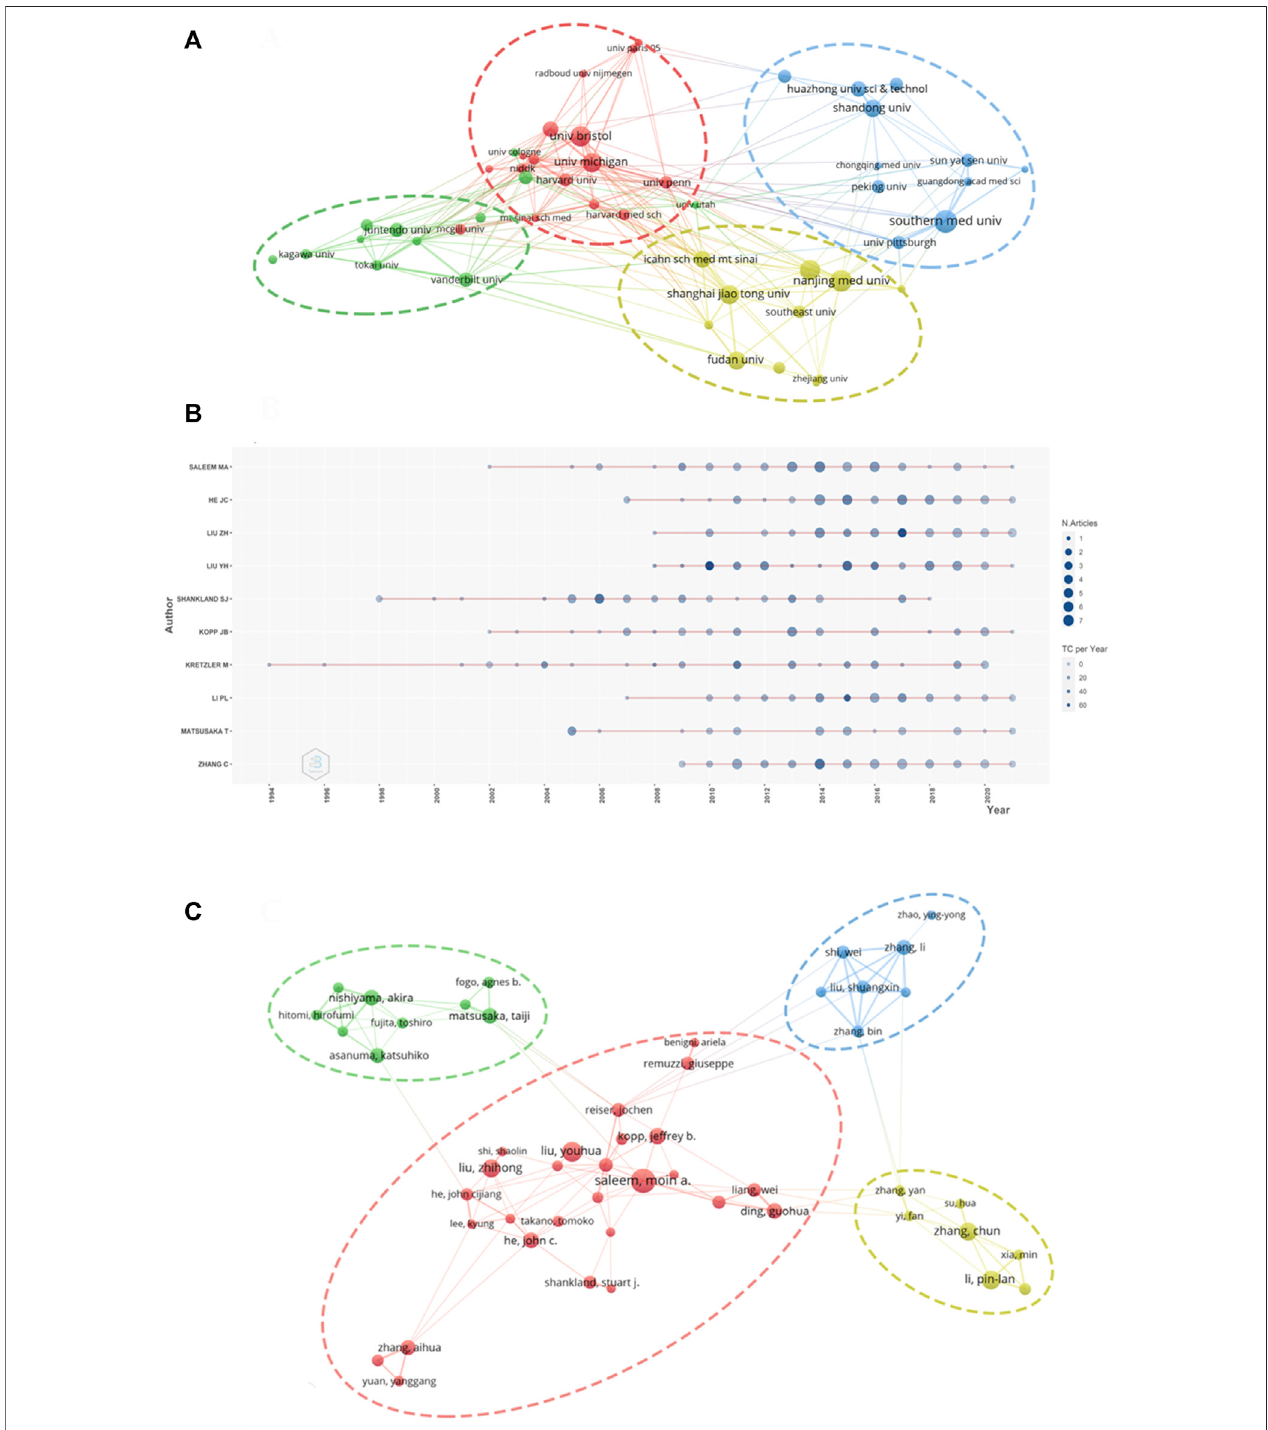
FIGURE 3 | Visualization of active institutes and authors analysis (A) Cluster analysis of cooperation among institutes; (B) Timeline distribution of the top 10 most productive authors; (C) Cluster analysis of cooperation among authors.